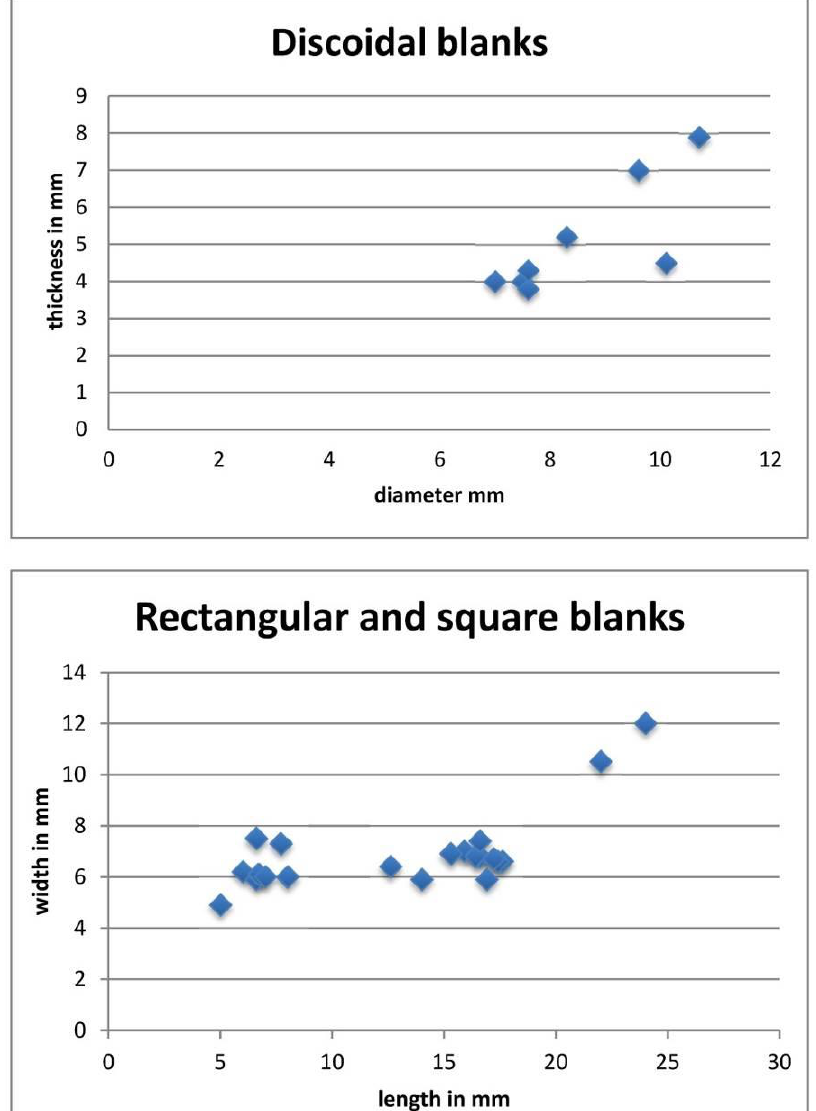
Figure 5. Chart showing dimensions of possible blanks from the Burnt Structure at Domuztepe (source Elizabeth